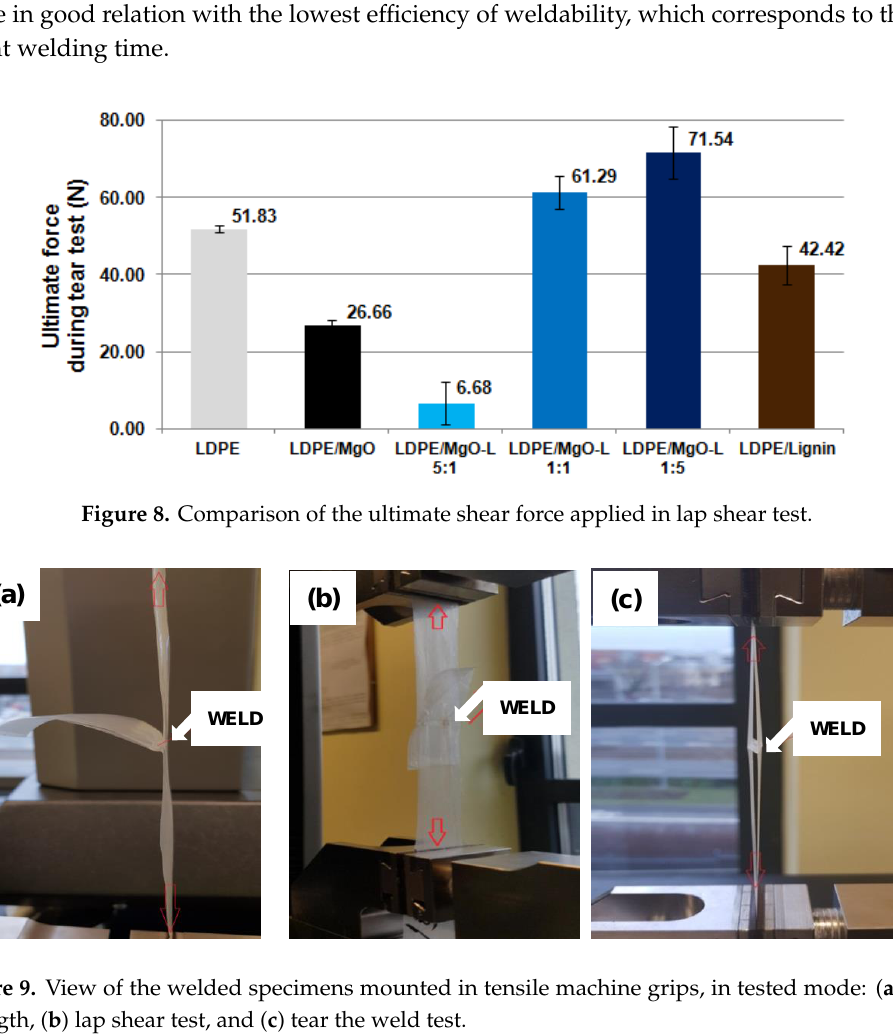
Figure 9. View of the welded specimens mounted in tensile machine grips, in tested mode: ( a ) seal strength, ( b ) lap shear test, and ( c ) tear the weld test.